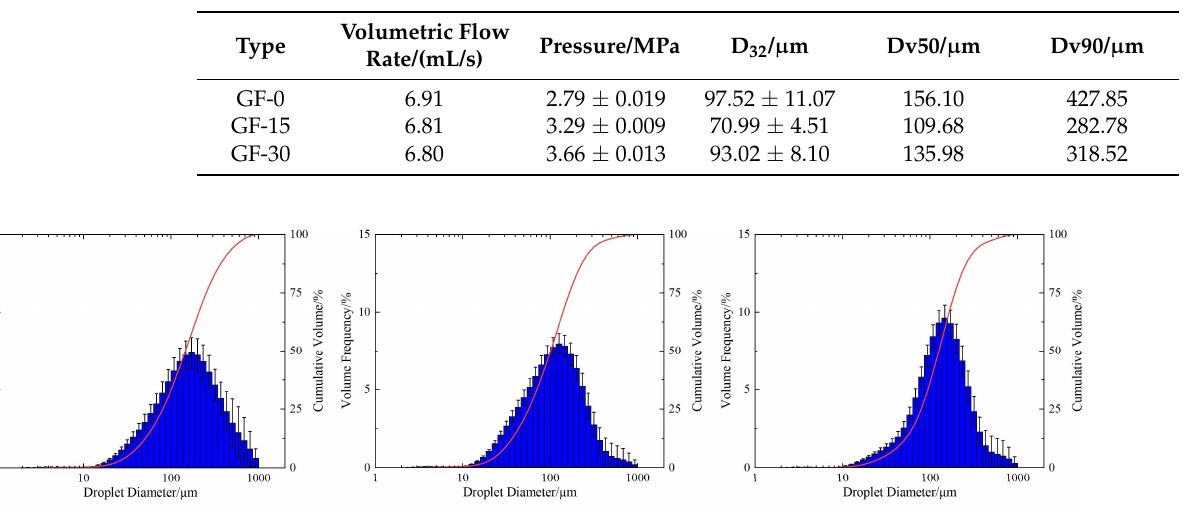
Figure 9. Spray images of different gelled fuels using self-excited oscillation nozzles. Table 4. The injection pressure and the mean droplet diameters of the self-excited oscillation nozzle for different gelled fuels.